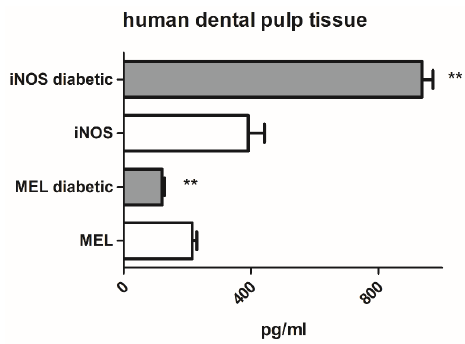
Figure 1. Inducible nitric oxide synthase (iNOS) and melatonin (MEL) protein expression in human dental pulp tissue from non-diabetic and type 2 diabetic patients. Each graph bar represents the mean ± SD of six to seven samples. ** p < 0.01.